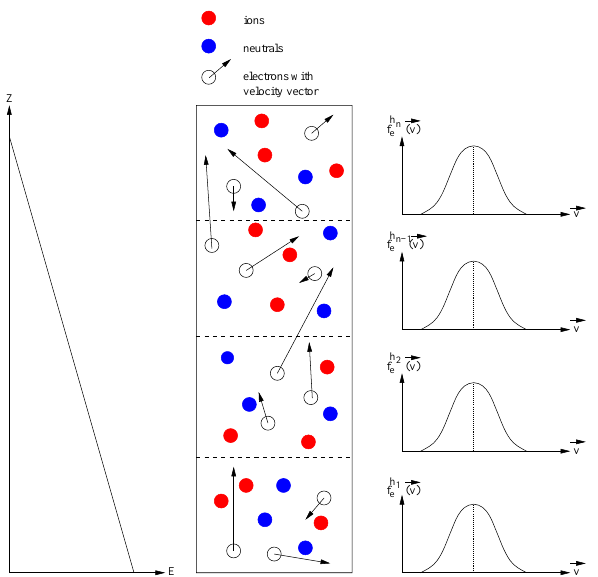
Fig. 4. Schematic illustration of the model for a plasma in the pres- ence of an electric field aligned in the z-direction. The electric field decreases with height. The particles’ velocities are 3-D even though the model is spatially 1-D. When a particle hits one of the bound- aries, it is re-injected into the system according to the electron ve- locity distribution function f hi e (v x ,v y ,v z ) . These boundary condi- tions are described in details in Sect.